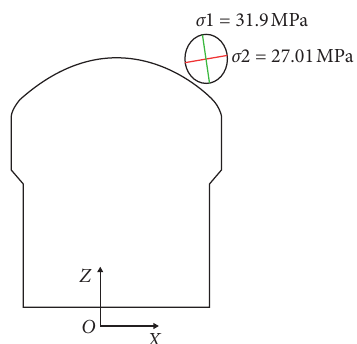
Figure 16: Stress distribution before excavation in section of the main powerhouse in Houziyan